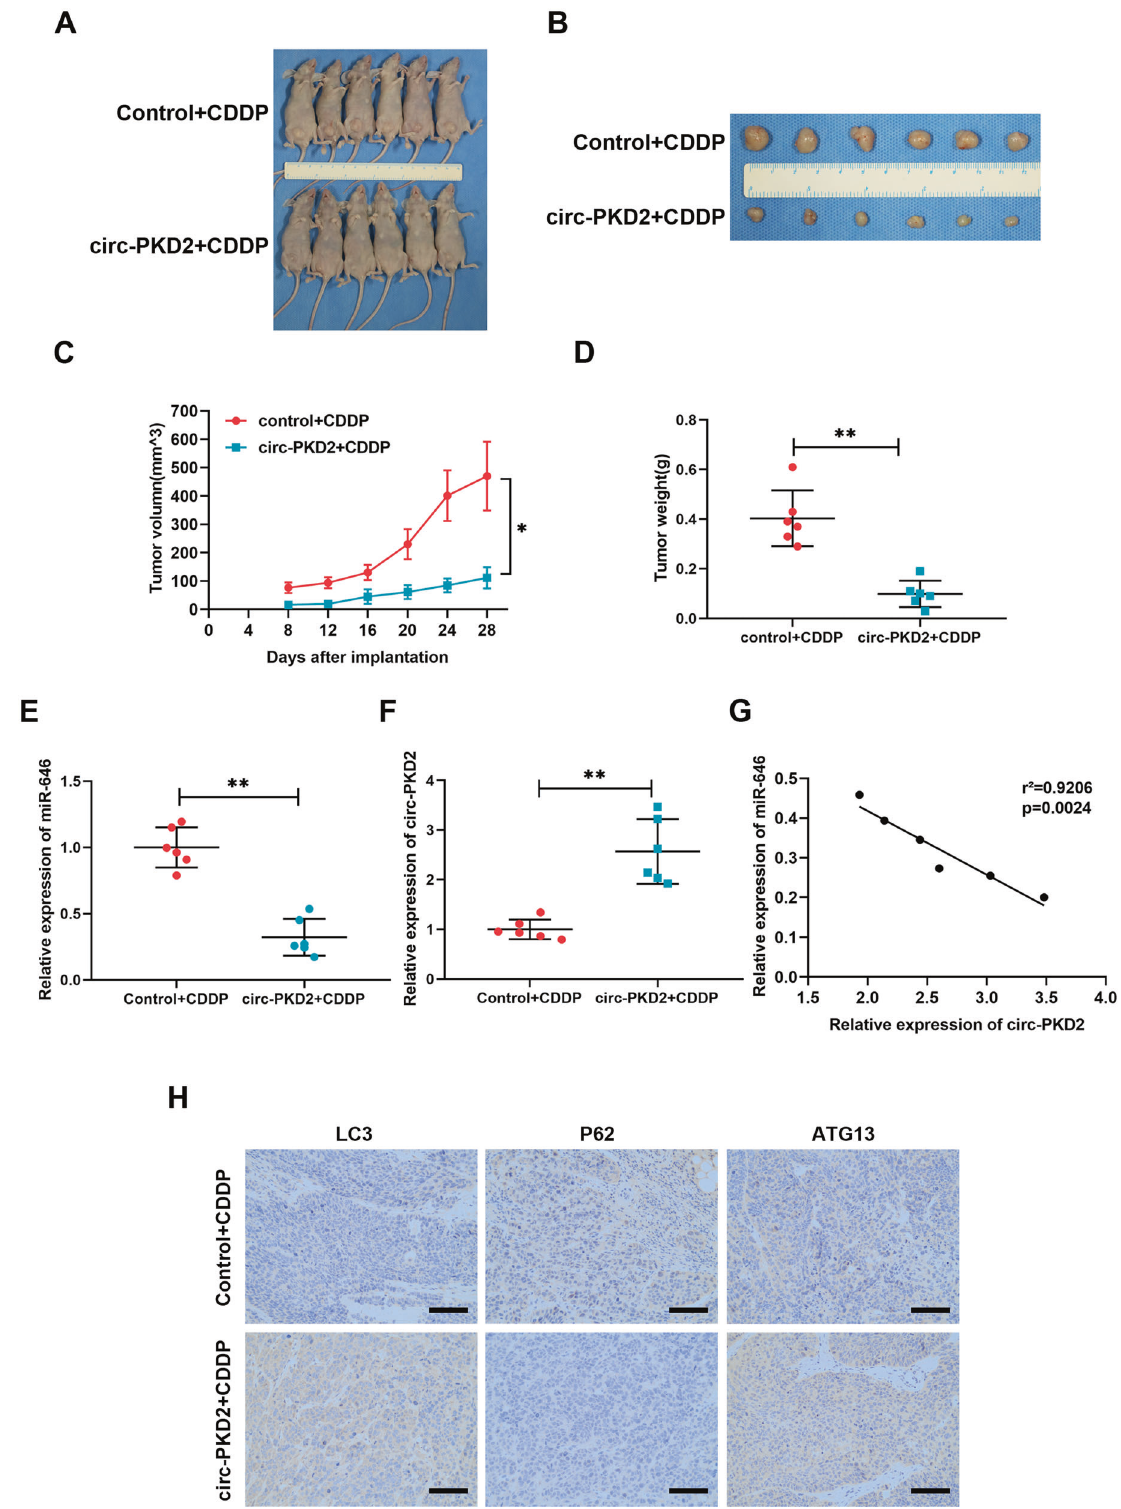
Fig. 5 Effect of circ-PKD2 overexpression on the sensitivity of cisplatin. A – D Tumor volumes, weight, and tumor growth curves of subcutaneous implantation models of SCC-15 cells. E The expression of miR-646. F The expression of circ-PKD2. G qRT ‐ PCR results are showing the correlation between circ-PKD2 and miR-646. H IHC results show the expression of LC3B, P62, and ATG13 in the circ-PKD2 overexpressing and control groups. * p < 0.05, ** p < 0.01.